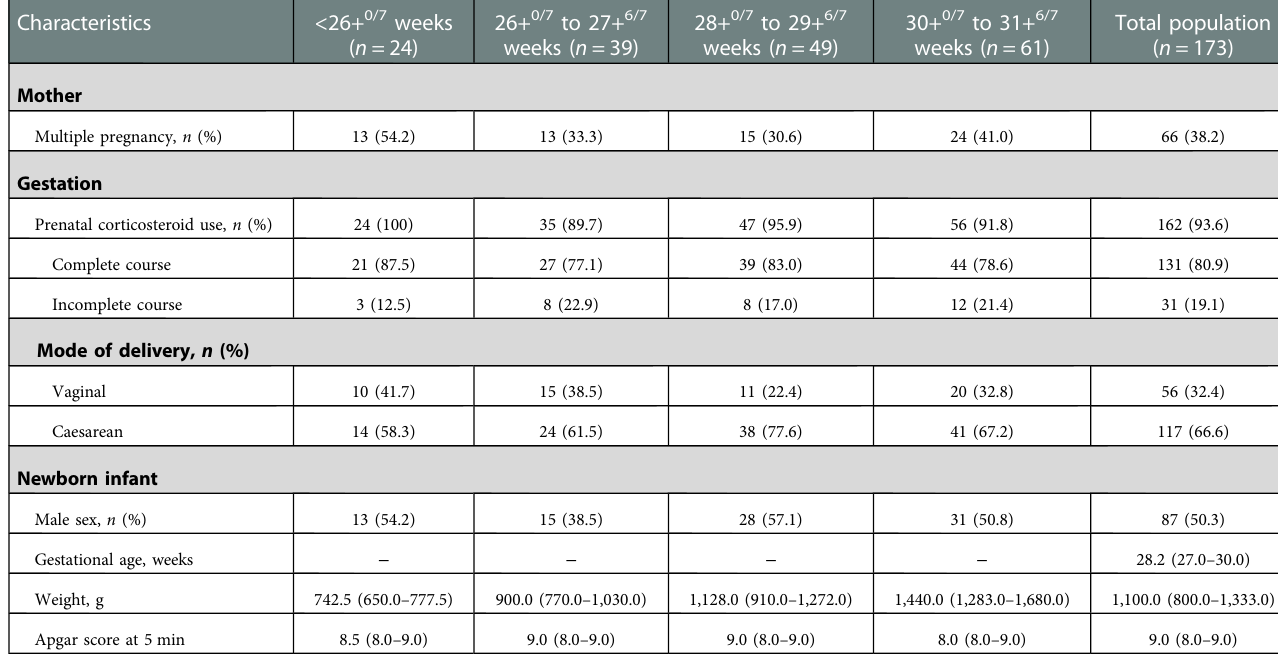
TABLE 1 Characteristics of the patients included in the VENTIS study by gestational age.